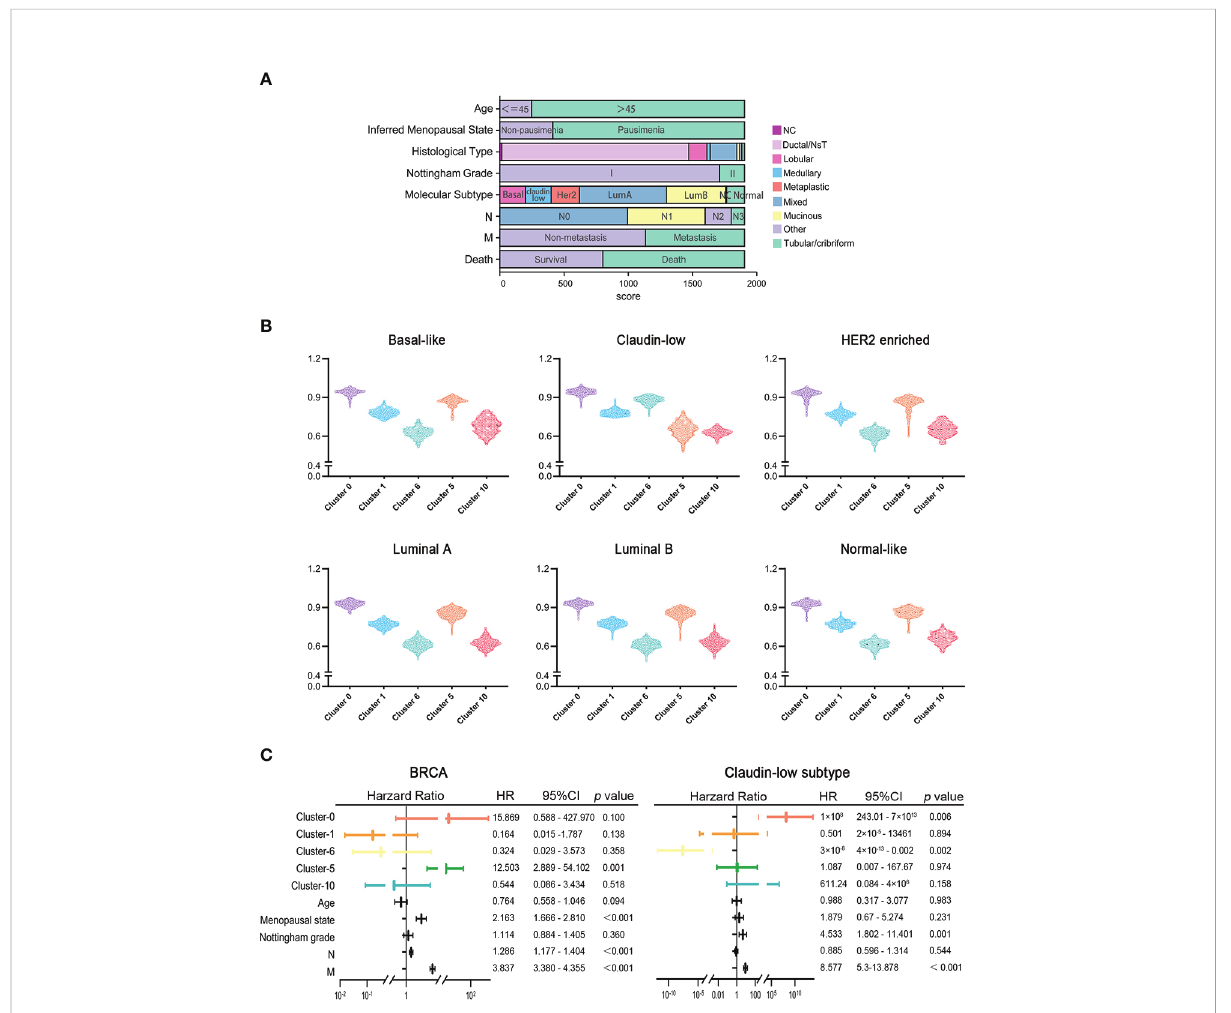
FIGURE 5 (A) The clinicopathological factors of 1,904 human breast cancers. (B) Comparisons of hypoxia-dependent spatial subgroup scores of cluster 0, cluster 1, cluster 6, cluster 5, and cluster 10 in different breast cancer subtypes. (C) Multivariate Cox proportional hazards regression model for hypoxia-dependent spatial clusters score and clinicopathological factors in all breast cancer and claudin-low